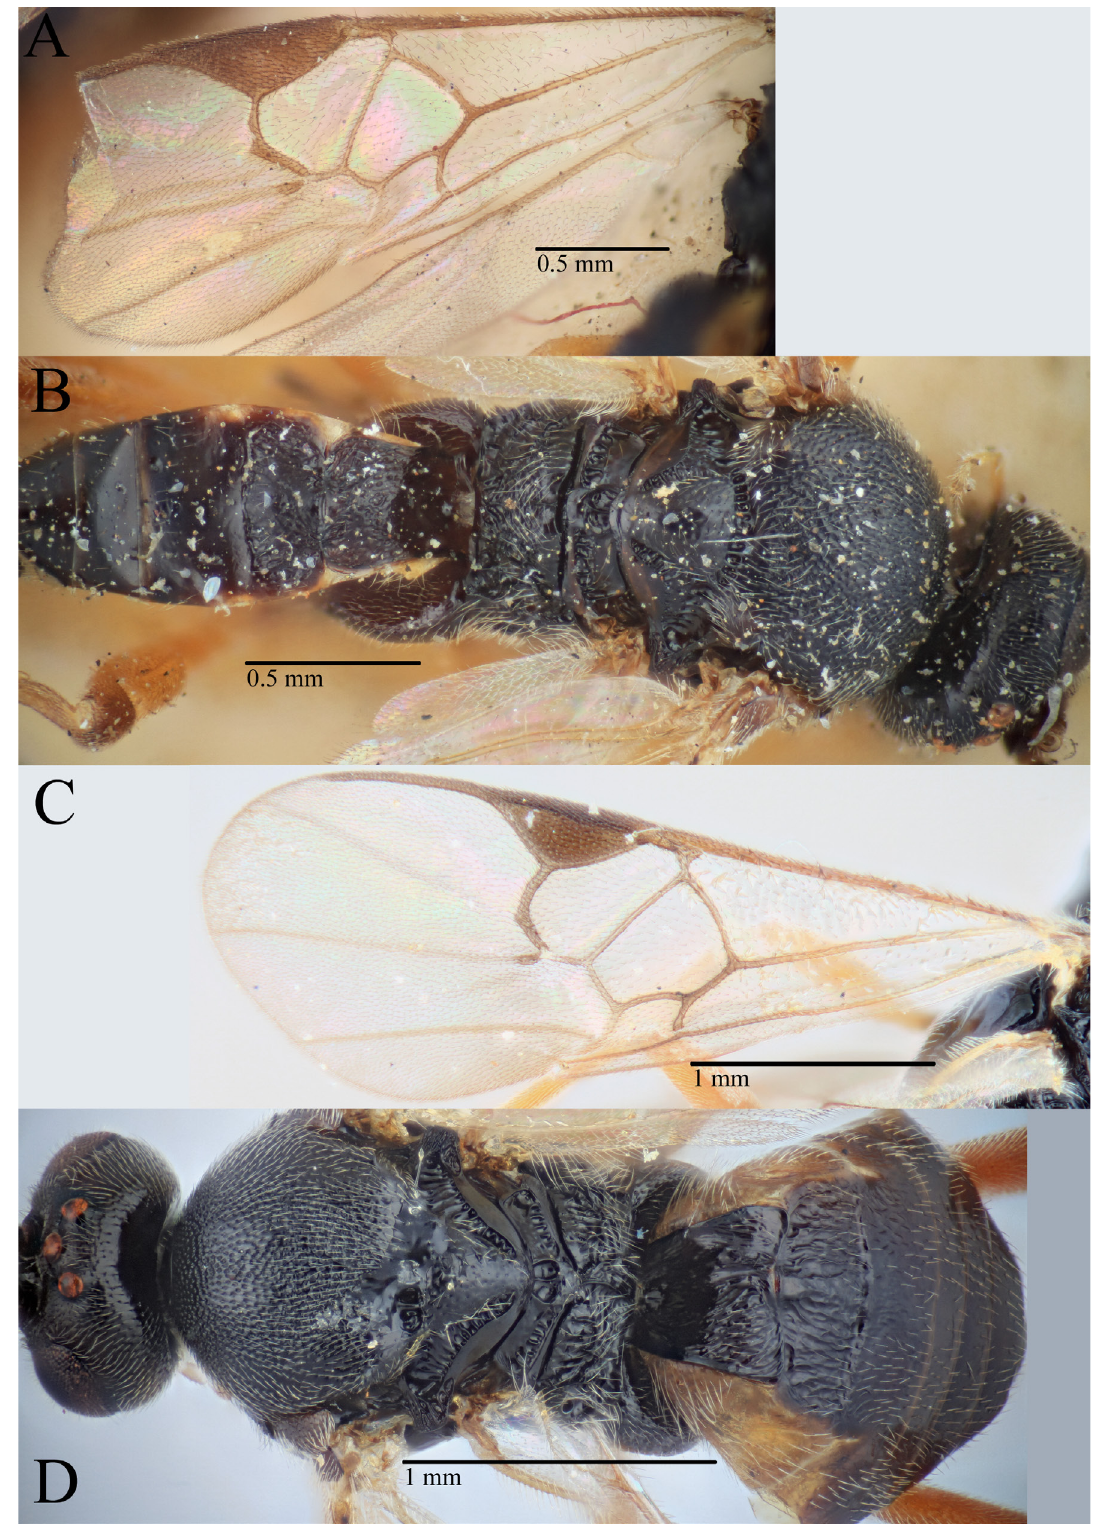
Fig. 23. A–B . Cotesia philoeampa (Cameron, 1911), lectotype, ♀ (NHMUK 3.c.997). A . Fore wing. B . Habitus in dorsal view. C–D . C. rubecula (Marshall, 1885), ♀, Urrbrae (WINC). C . Fore wing D . Habitus in dorsal